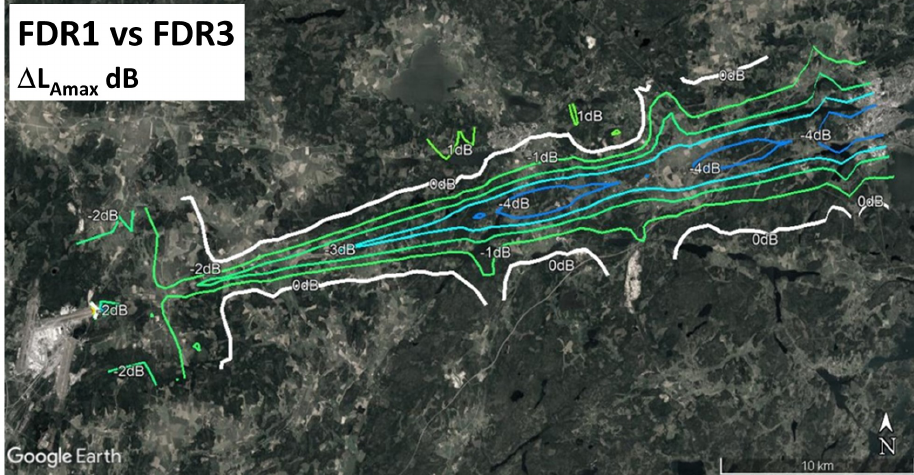
Figure 13. Noise prediction difference of FDR1 with respect to FDR3 using SAFT ECAC Doc 29